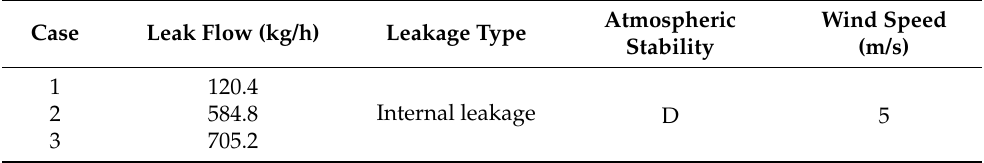
Table 6. Parameters of leaked